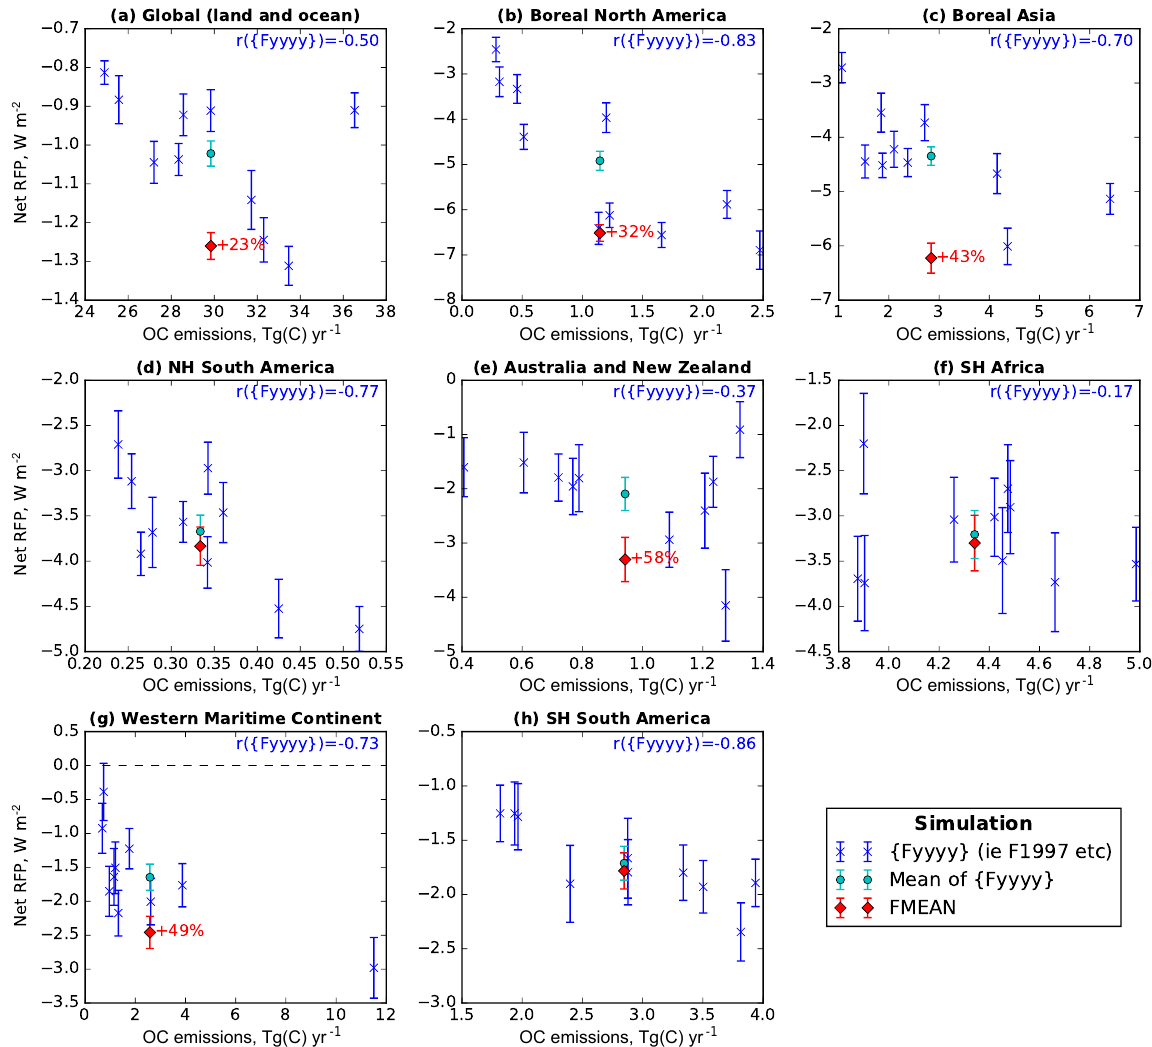
Figure 5. Net radiative flux perturbation (RFP) vs. organic carbon (OC) emissions for the globe and seven different regions. The RFPs are relative to simulation F0. Each point represents the results for a different simulation or group of simulations (in the case of the mean of { Fyyyy } ). Error bars represent combined standard error (see Fig. 3 caption). The Pearson’s product–moment correlation coefficient ( r ), calculated from the 10-member { Fyyyy } ensemble (blue points), is shown in blue text at the top right of each panel. For regions where the FMEAN– { Fyyyy } difference is statistically significant at two-tailed p < 0 . 05 (tested using Welch’s t test, using annual mean data as the input), the FMEAN– { Fyyyy } percentage difference (relative to { Fyyyy } ) is shown in red